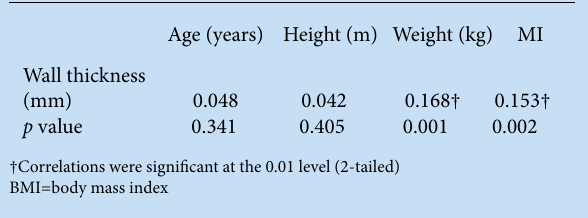
Table II. Correlation between mean gallbladder wall thickness and body parameters of the